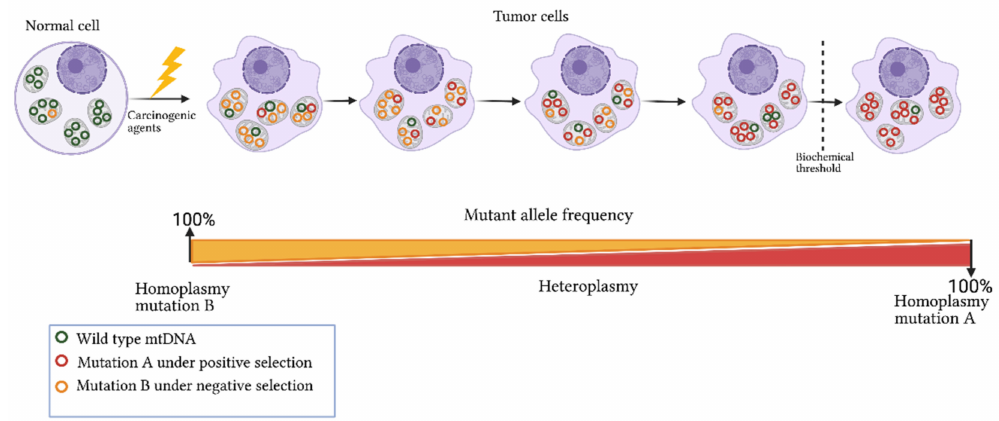
Figure 2. Dynamics of mitochondrial mutations in cancer. Exposure of a normal cell to carcinogenic agents leads to somatic mutation acquisition in mtDNA and changes in the germline mutation heteroplasmy. The frequency of acquired mutation can increase or decrease in tumor cells based on its nature and biological effect. For instance, if a mutation confers advantages to cell proliferation and survival, it will be selected and enriched in the tumor cell (mutation A). In contrast, a mutation compromising cell viability will be selected negatively (mutation B). Biochemical and phenotypic manifestation of the mtDNA mutations occurs only when a threshold level is exceeded. Figure artwork created with